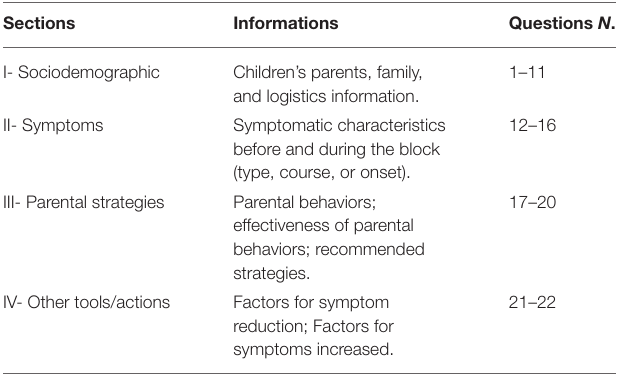
TABLE 1 | Structure and contents of the questionnaire: sections - information on the questions - number of questions. Sections